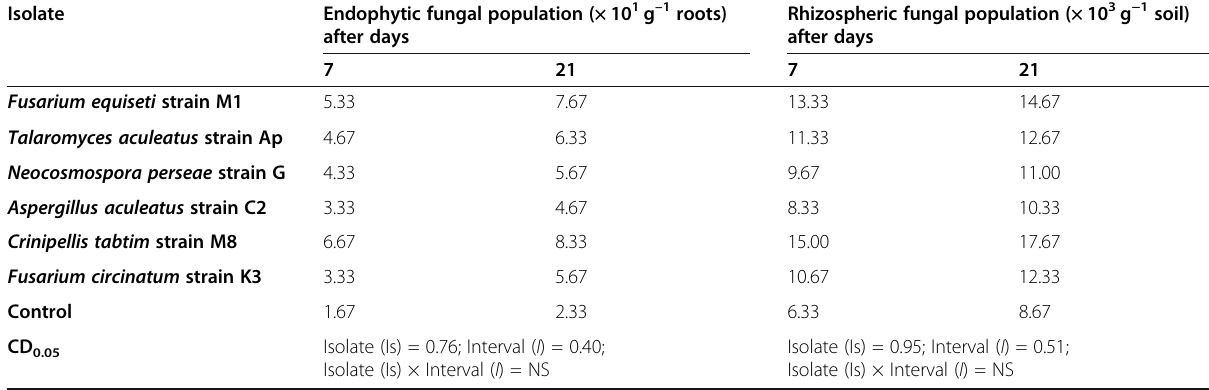
Table 5 Enumeration of endophytic and rhizospheric fungal population after seedling dip treatment of apple with endophytic suspension in pot conditions